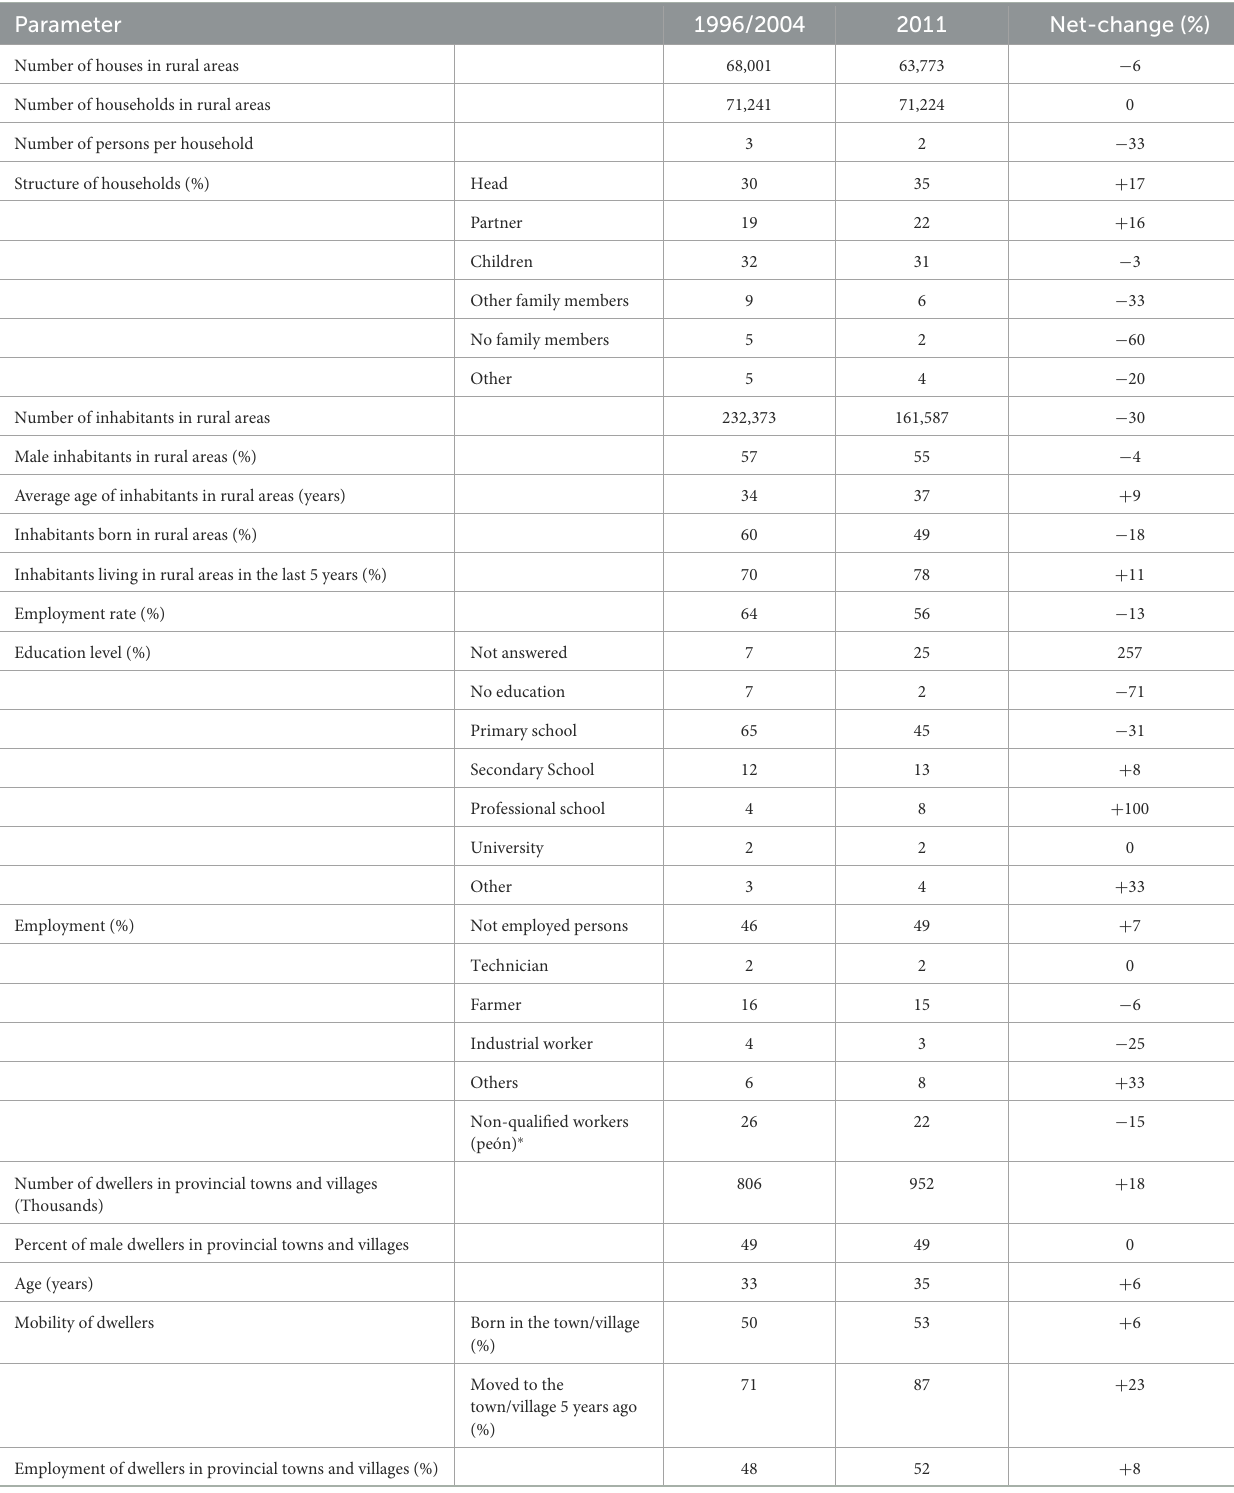
TABLE 1 Socio-demographic parameters of land-use change in rural Uruguay following the National Population Census (INE 1996, 2004, 2011).